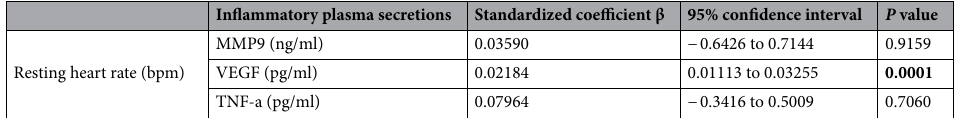
Table 5. Multiple linear regression analysis: RHR as a dependent variable, relative to serum inflammatory factors. Bold values denote statistical significance.